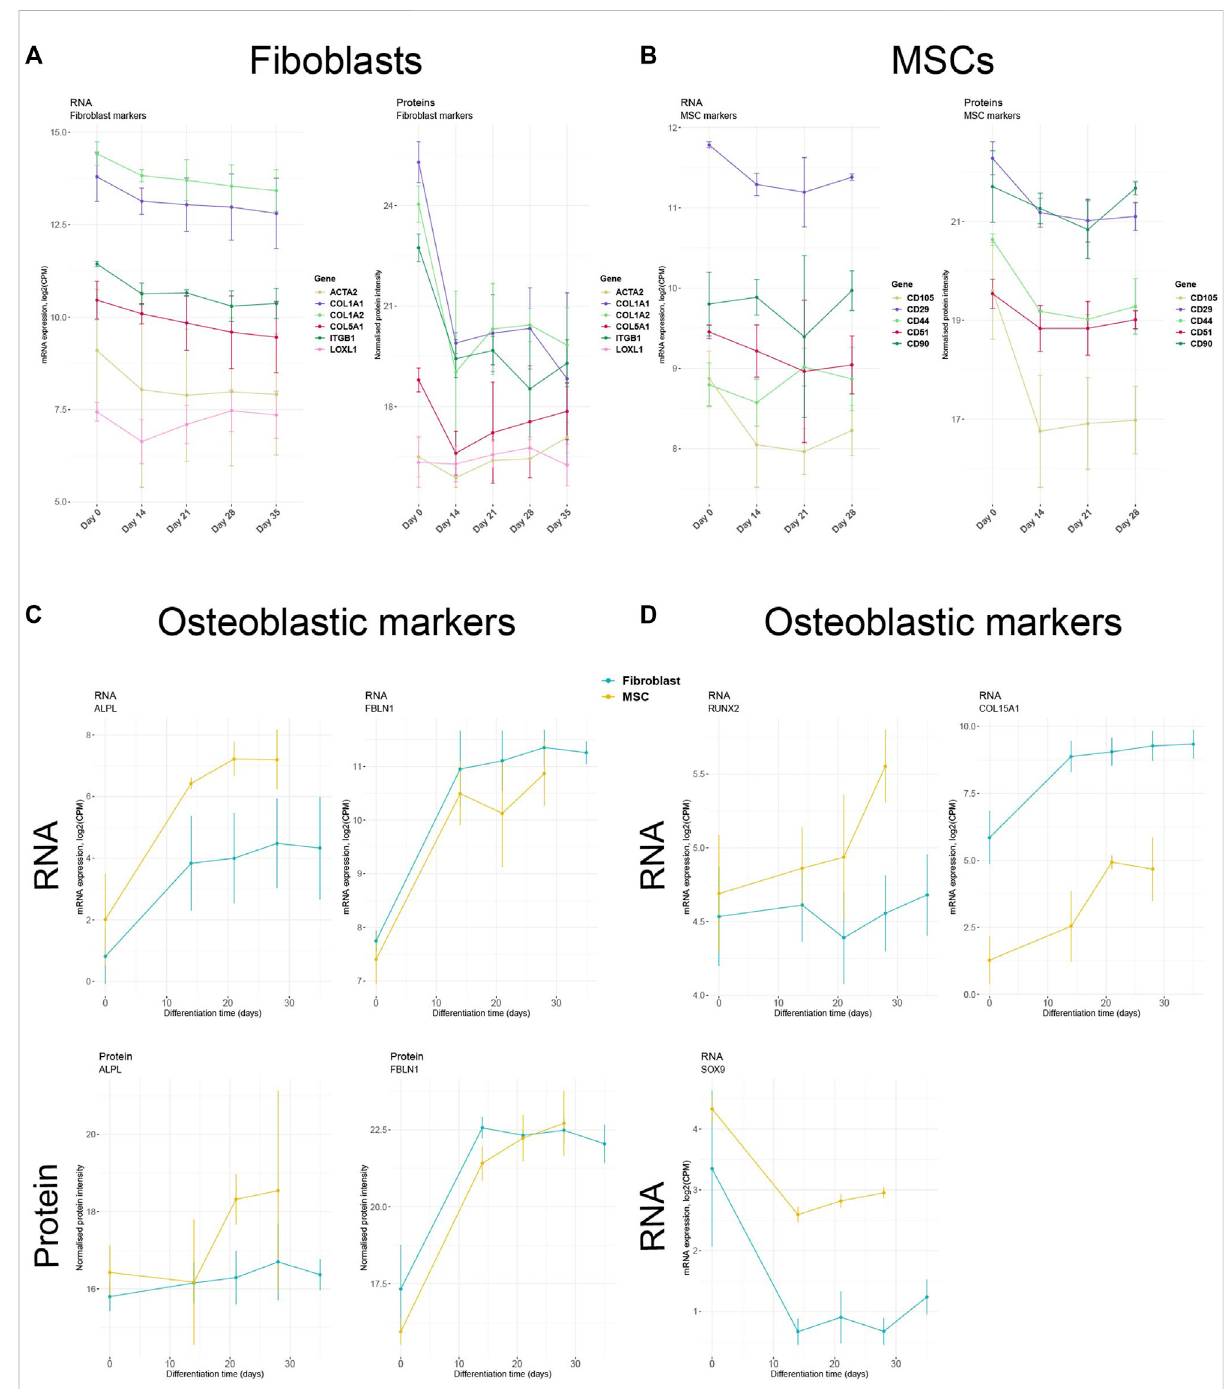
FIGURE 8 Decreasedexpressionofcelltype-speci fi cmarkersandincreasedexpressionofosteoblastmarkers (A) Expressionpro fi lesofselected fi broblast markers in fi broblasts and (B) selected MSC markers in MSCs during osteoblastic differentiation treatment. (C) RNA and protein or (D) only RNA expression of essential osteoblastic markers in MSCs and fi broblasts. For mRNA expression plots, log2-transformed counts per million (CPM) values were used. For protein expression plots, normalized and imputed proteomics data were